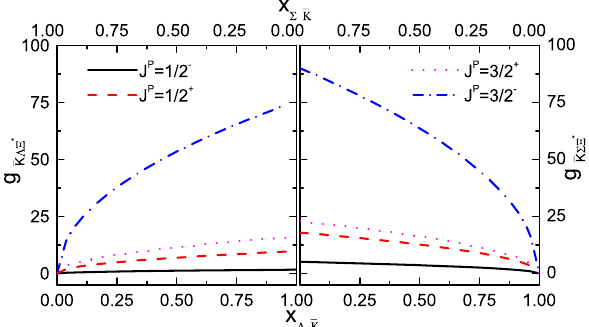
Fig. 4 Coupling constants of the Ξ( 1620 ) with different J P assign- ments as a function of the parameter X Σ ¯ ability to find the Ξ( 1620 ) 0 in the hadronic components ¯ K Σ and ¯ K Λ , respectively